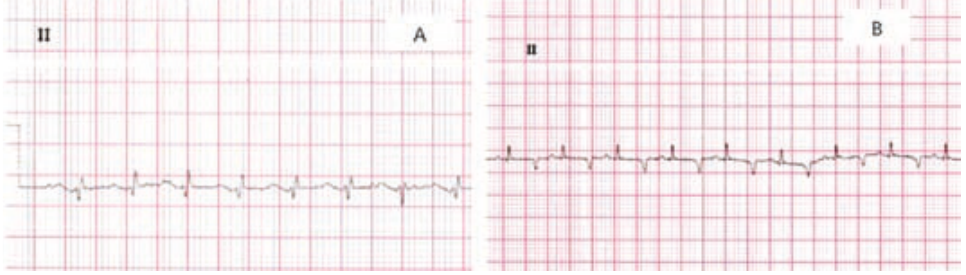
Fig. 9. ECG of animal number S3 before and after treatment (Paper speed – 25 mm/sec). A – Atrial standstill and sino-ventricular rhythm before treatment. B – Sinus rhythm with first- degree AV block and prolonged QT interval (lengthening of ST segment) after treatment